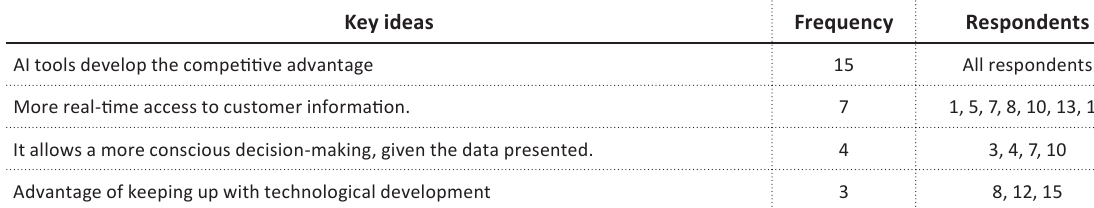
Table 5. Commercial perspective on competitive advantage in using AI tools Key